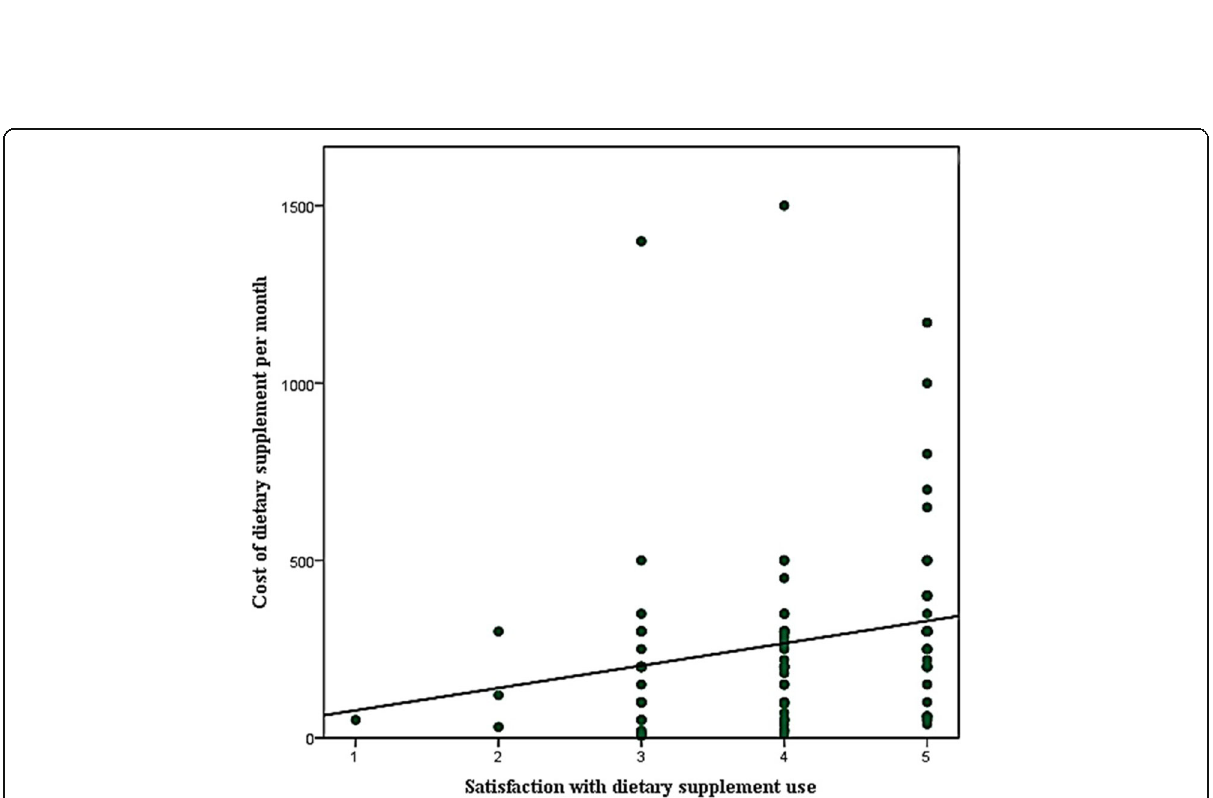
Fig. 2 Correlation of cost of dietary supplement with satisfaction